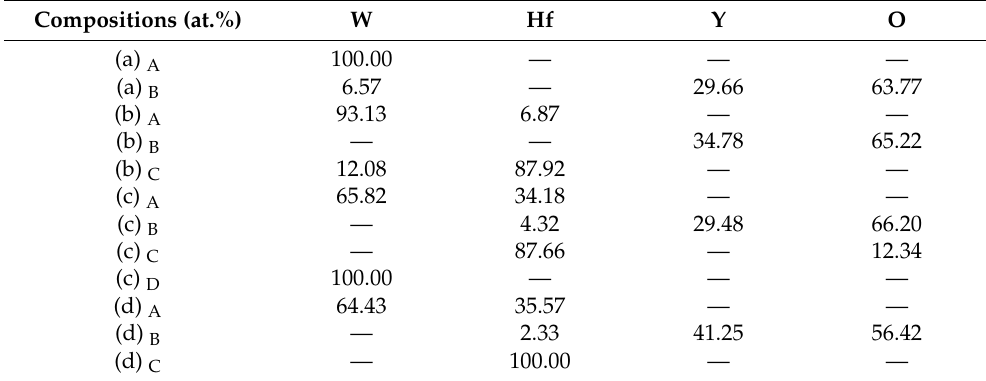
Table 2. EDS analysis results revealing the element content at different points in Figure 2. Compositions (at.%)